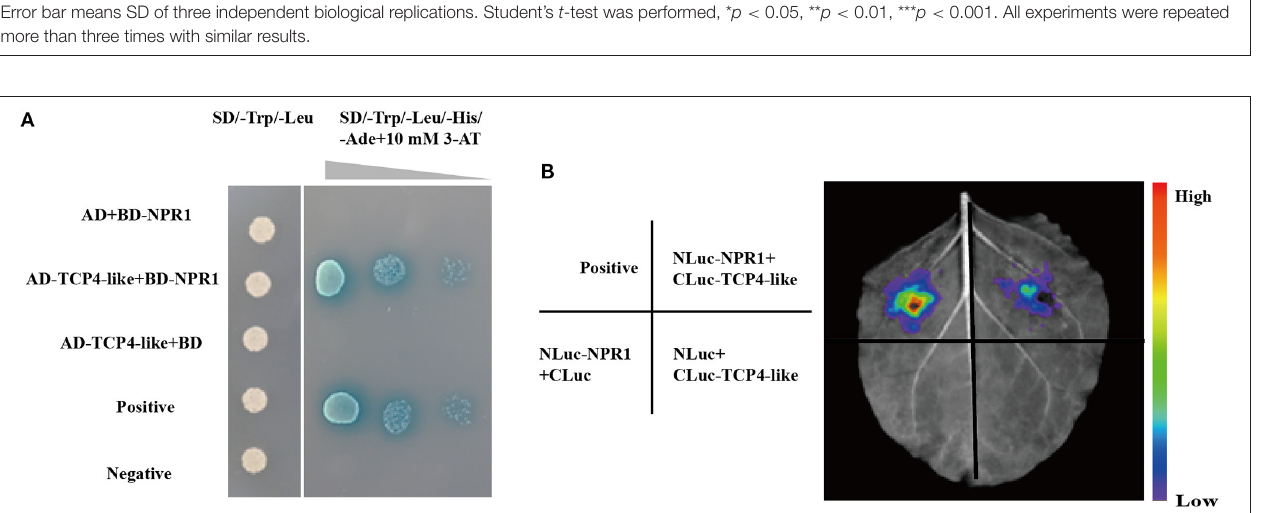
FIGURE 6 | GhTCP4-like interact with GhNPR1. (A) Yeast two-hybrid (Y2H) assay shows GhTCP4-like interaction with GhNPR1. All recombination yeast cells were grown on SD/-Trp/-Leu medium. After gradient dilution and sprayed 10mM 3-AT and 20 mg/ml X- α -Gal on SD/-Trp/-Leu /-His/-Ade medium. Yeast transformed with paired plasmid AD-largeT and BD-p53 were used as a positive control, AD-largeT and BD-laminC were used as a negative control. Photos were taken after 3 d at 28 ◦ C. (B) LCI assays to detect the association between GhTCP4-like and GhNPR1. Agrobacterium strains containing the indicated vectors were co-expressed in leaf cells of N. benthamiana . The luminescence signal was detected by applying 1mM luciferin after 48h of agroinfiltration. The positive control was constructed according to Chen et al. (2008). The colored scale indicates the intensity of luciferin activity. All experiments were repeated more than three times with similar